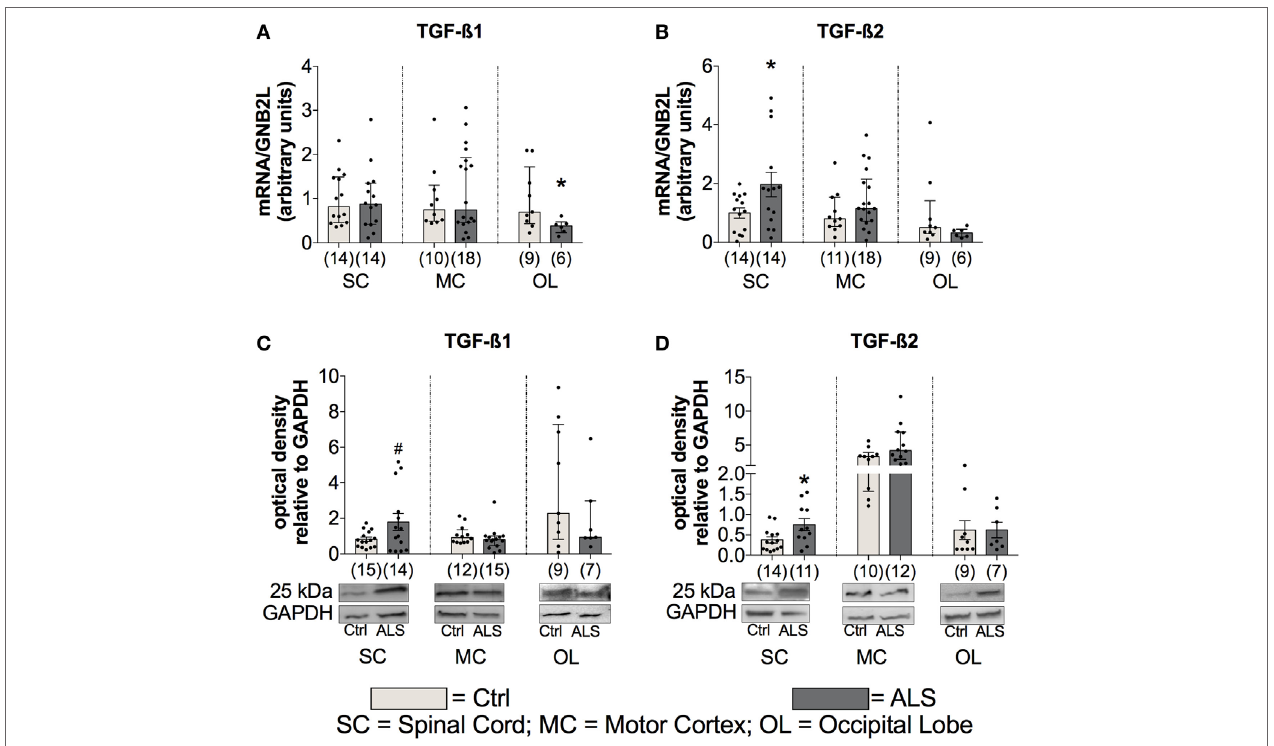
FigUre 5 | Tissue concentrations of TGF­ β 1 and TGF­ β 2. Tissue of Amyotrophic lateral sclerosis (ALS) patients displayed no alterations of TGF­ β 1 mRNA and protein expression levels (a) , but increased mRNA as well as protein expression levels of TGF­ β 2 (b,D) and a strong trend toward an enhanced protein expression of TGF­ β 1 within the spinal cord (SC; D ). * p < 0.05 vs. controls (Ctrl), # = trend, p = 0.0538. Numbers of patients are given in brackets; all parameters were tested for Gaussian distribution using D’Augostino­Pearson omnibus normality test. Two­tailed unpaired Student’s t ­test for TGF­ β 1 protein (SC) and TGF­ β 2 mRNA (SC) and protein (SC, OL), data represent mean ± SEM; two­tailed Mann–Whitney test for TGF­ β 1 mRNA (SC, motor cortex (MC)), occipital lobe (OL), protein (MC, OL), TGF­ β 2 mRNA (MC, OL), and TGF­ β 2 protein (MC), data represent median with interquartile range. TGF­ β 1 and TGF­ β 2 protein expression levels were quantified and represented relative to the expression levels of the housekeeping protein